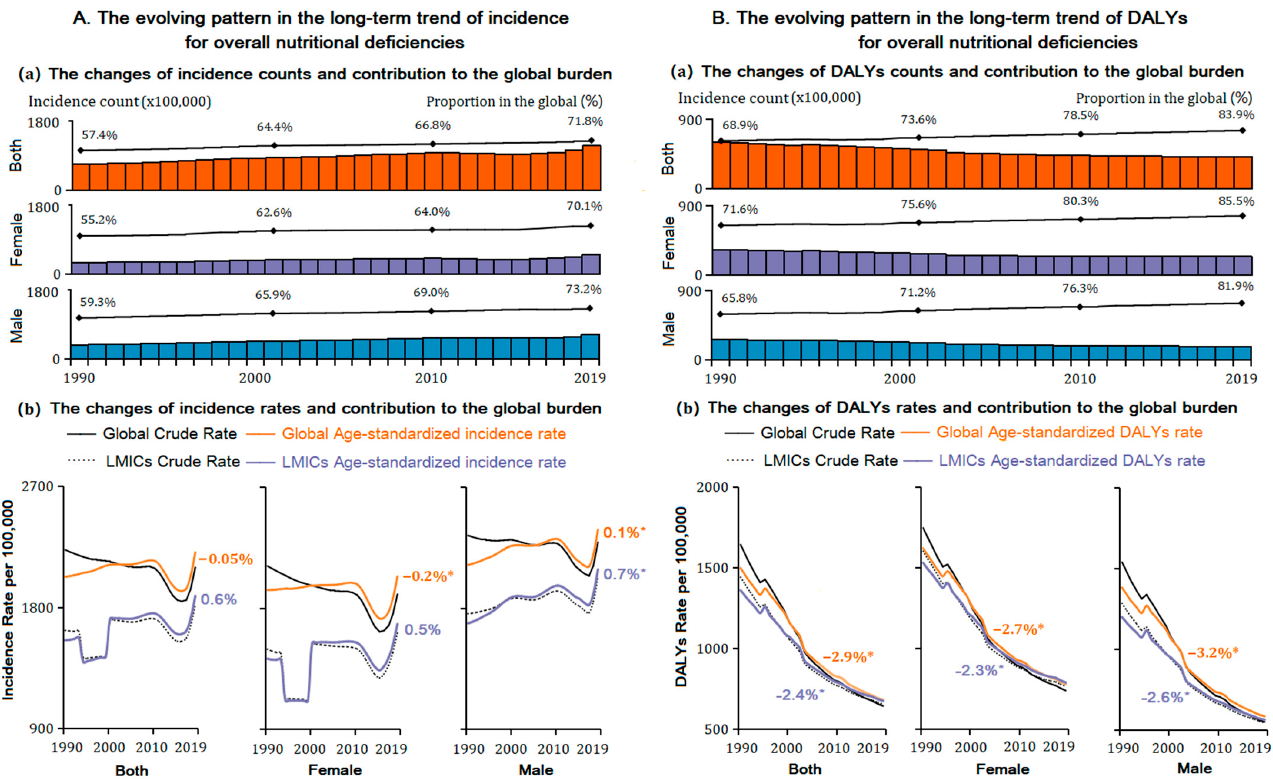
Figure 1. The sex-specific incidence and DALYs counts, age-standardized rate, and their trend for nutritional deficiencies (NDs) in LMICs from 1990 to 2019, and their contribution to the global burden. ( A ) Incidence; ( B ) DALYs. DALYs = disability-adjusted life years. Note: (*) Indicates statistically significant trend (p < 0.05).